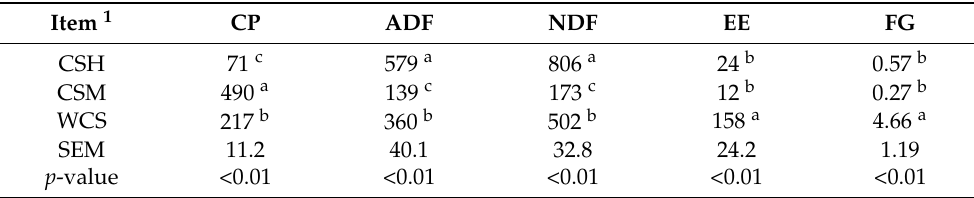
Table 1. Nutrient compositions and free gossypol (FG) contents of cottonseed and its by-products (g/kg